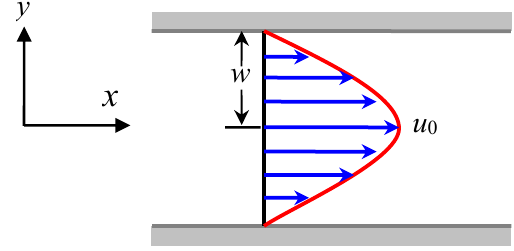
Figure 2. Schematic diagram of the steady-state plane Poiseuille flow. The blue arrows show the flow direction as well as the corresponding strength, the red curve represents the velocity profile, w and u 0 are respectively the half width of the tube and middle axis velocity.